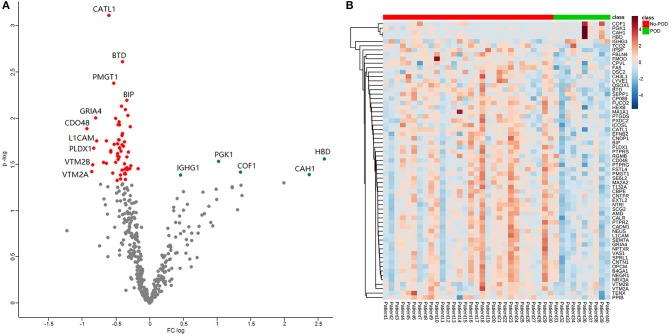
Volcano plot and heat map. Volcano plot showed the distribution of the 412 quantitative proteins in terms of fold change and P-value (A). Heat map showed the expression profile of the 63 dysregulated proteins (B).